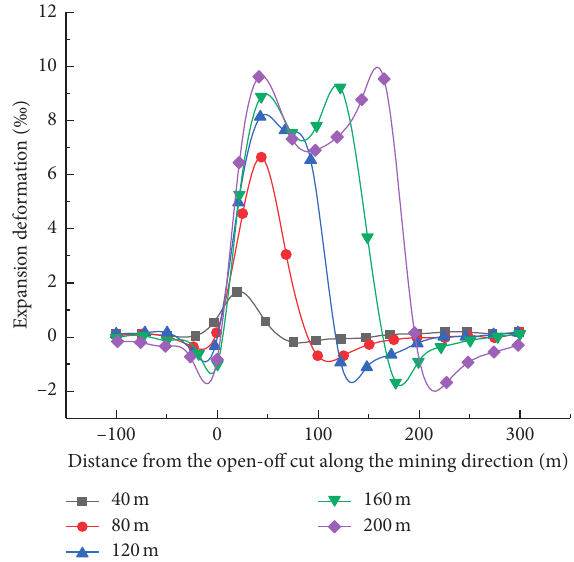
Figure 7: Vertical displacement curve for the No.2-1 coal seam in the mining of the rock-coal composite protective layer.